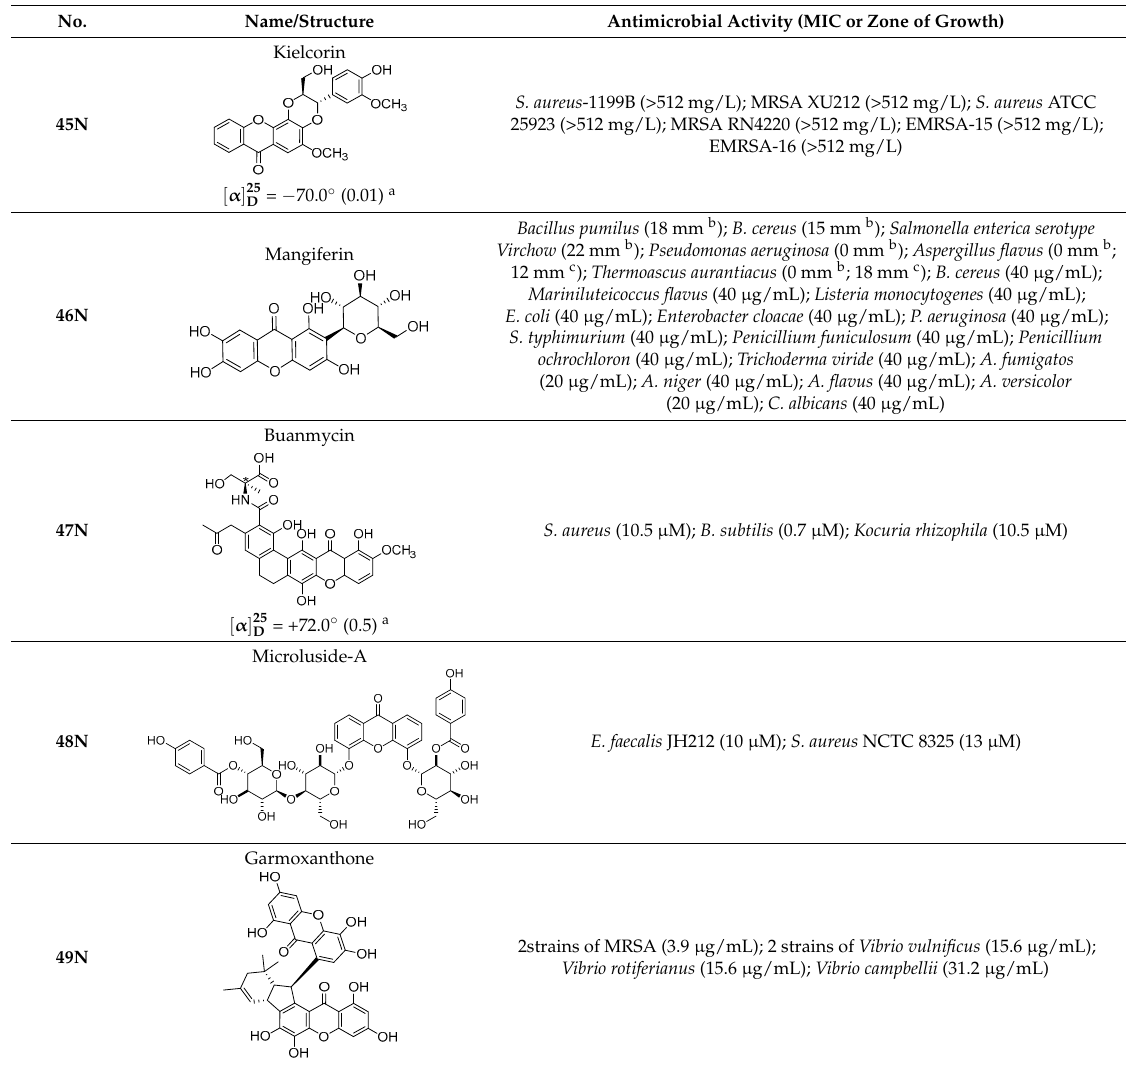
Table 6. Antimicrobial activity of other natural CDXs.